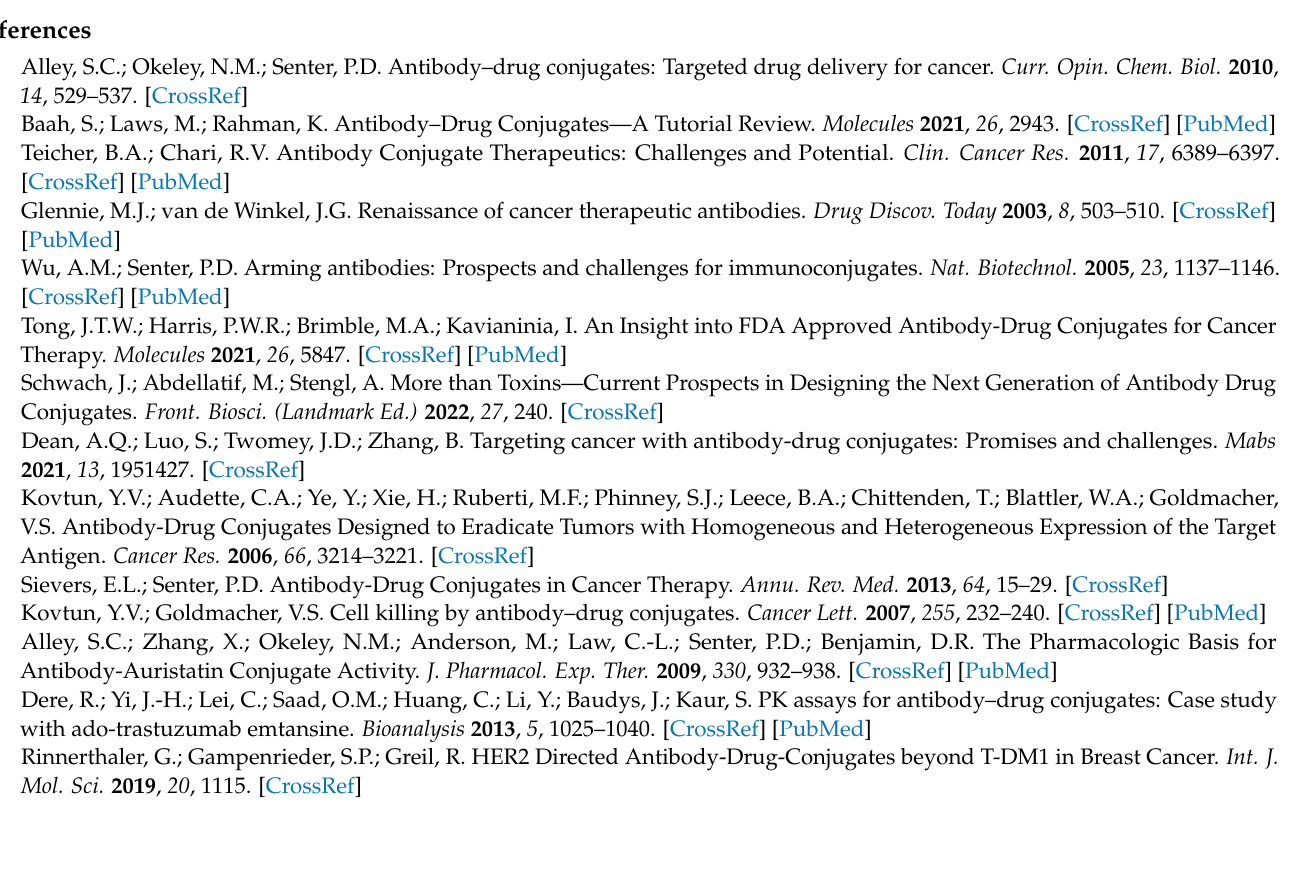
Table S5: Matrix Effects (Selectivity) of ELISAs for T-DM1 in Rat; Table S6: Stability of ELISAs for T-DM1 in Rat; Table S7: Calibration Standards of LC–MS/MS for DM1 in Rat; Table S8: Accuracy and Precision of LC–MS/MS for DM1 in Rat; Table S9: Stability of LC–MS/MS for DM1 in